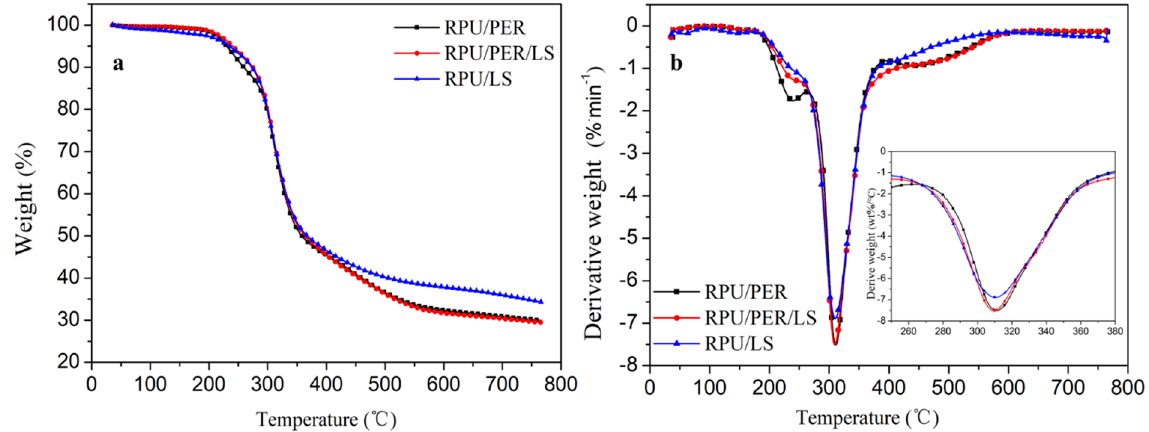
Figure 3. TG ( a ) and DTG ( b ) curves of RPU/PER, RPU/PER/LS, and RPU/LS foams under nitrogen atmosphere.